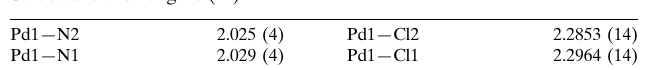
Selected bond lengths (A˚ ).